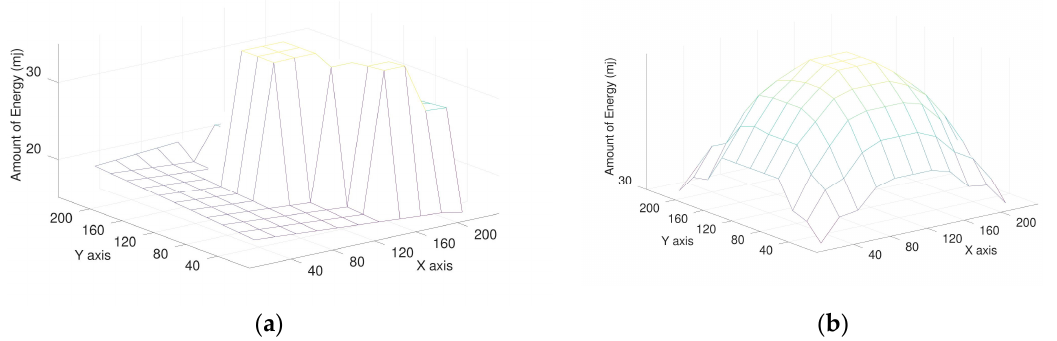
Figure 9. ( a ) a snapshot of energy deployment with MCP; ( b ) a snapshot of energy deployment with FCP. The least in MCP is 15 mJ, and the least in FCP is 30mJ at the same time.